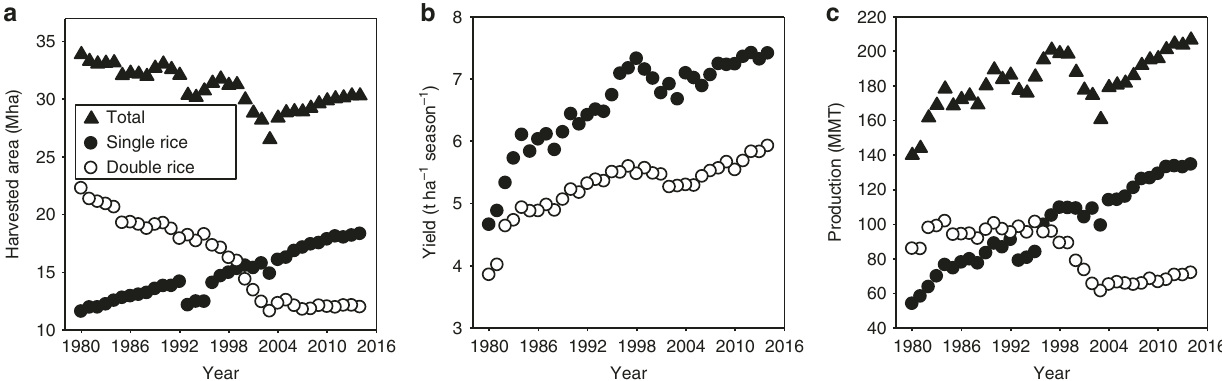
Fig. 1 Rice production trends in China. Trends in harvested rice area ( a ), rice yield ( b ), and total production ( c ) for single- and double-rice cropping systems during the past 35 years (1980 – 2014) in China. Note that the yield for double-rice is on a per-harvested area basis so that total annual yield is twice the values shown. Data were obtained from ref. 1 . Mha million hectares, MMT million metric tons. Source data are provided as a Source Data fi